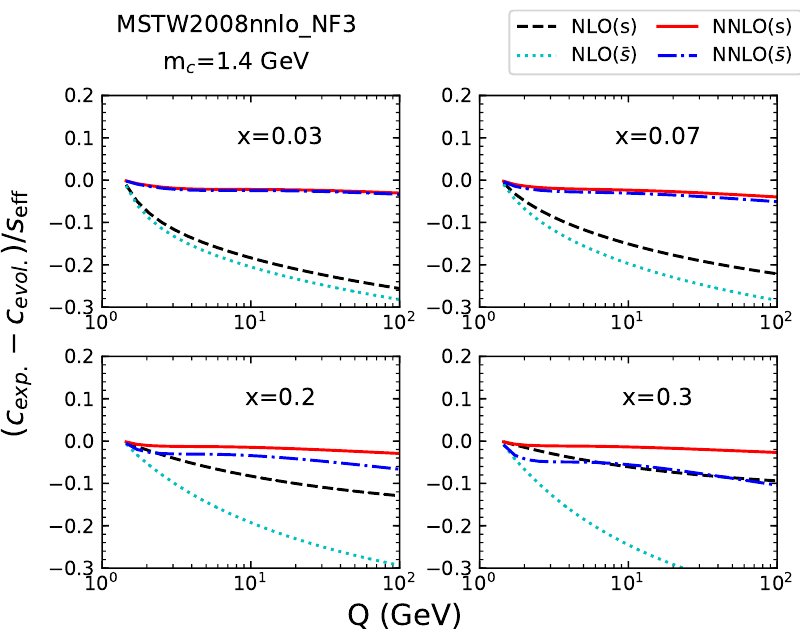
Figure 7 . Di(cid:11)erences of an evolved charm-quark PDF c at NNLO and the expanded solution evol: ) (NLO) and O ( (cid:11) 2 ) (NNLO) as a function of (cid:22) = Q for several x values, normalized c exp: up to O ( (cid:11) S S to the e(cid:11)ective strangeness PDF s e(cid:11) . See text for more